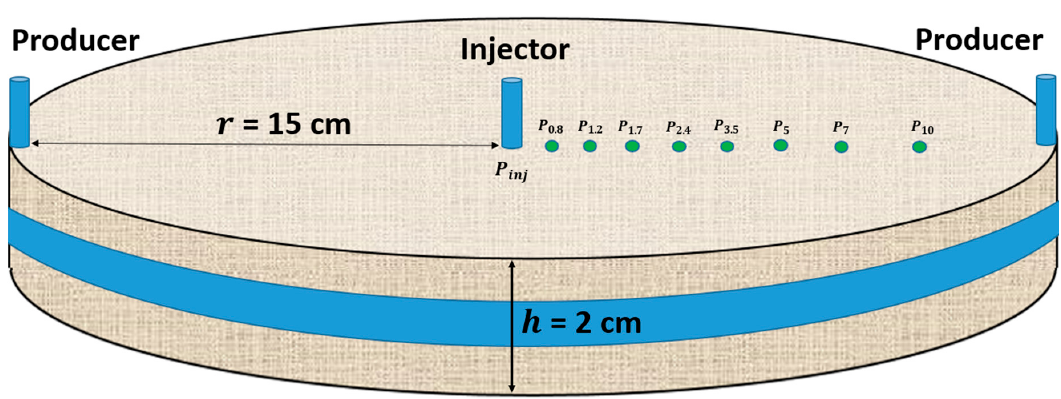
Figure 1. Schematic representation of the circular Bentheimer disc showing the distribution of internal pressure ports mounted between injection well and production line.